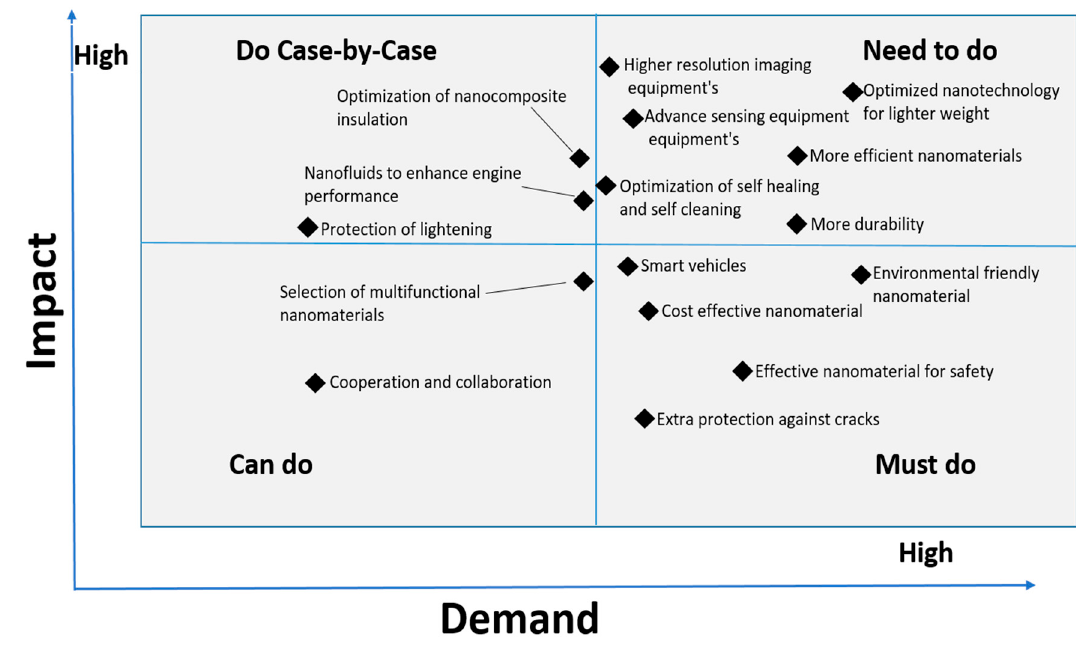
Figure 4. Impact of and demands for nanotechnology applications in the transportation vehicle industry.